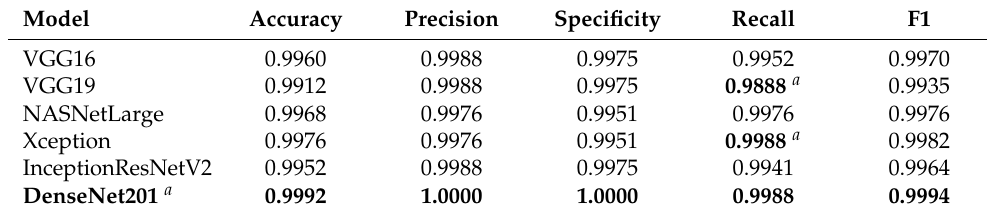
Table 1. Pre-trained Models’ Results on the Test Set.